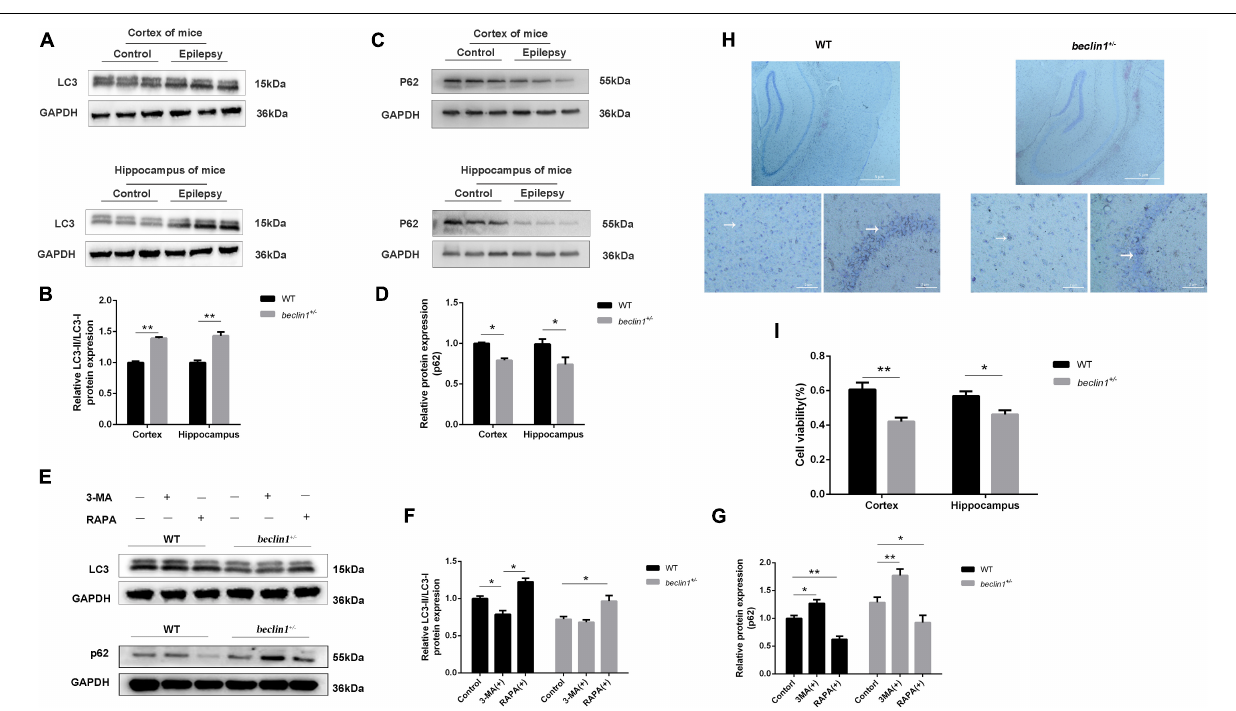
Frontiers in Molecular Neuroscience |